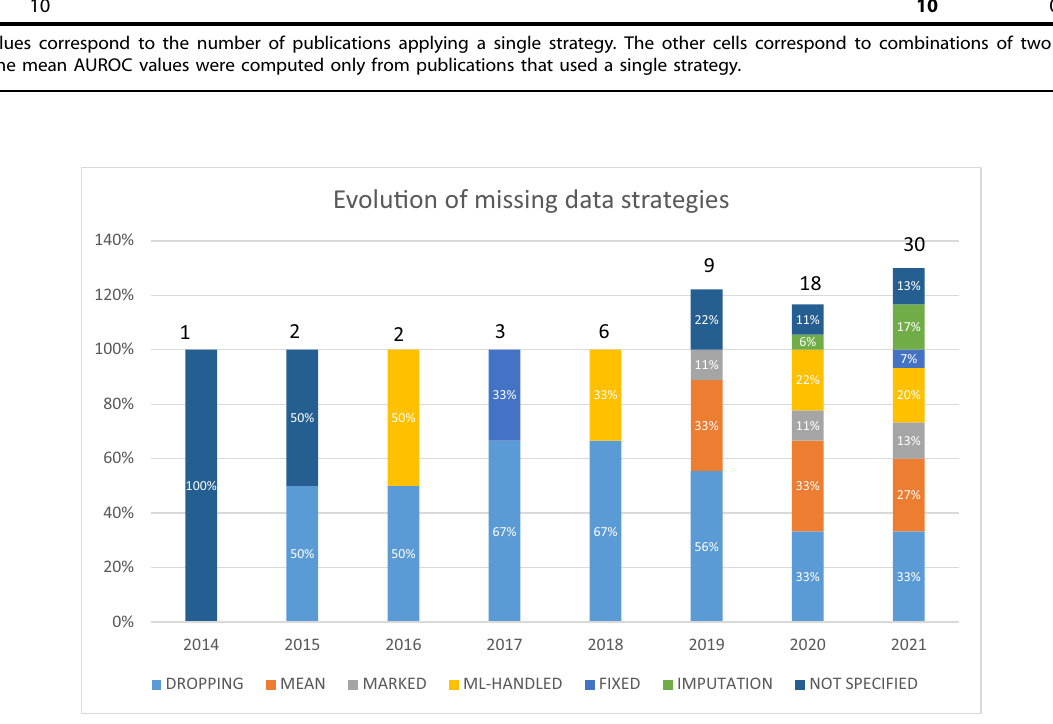
Fig. 3 Change over time in the frequency of use of missing data strategies. NB: some publications used more than one strategy, and so the total can exceed